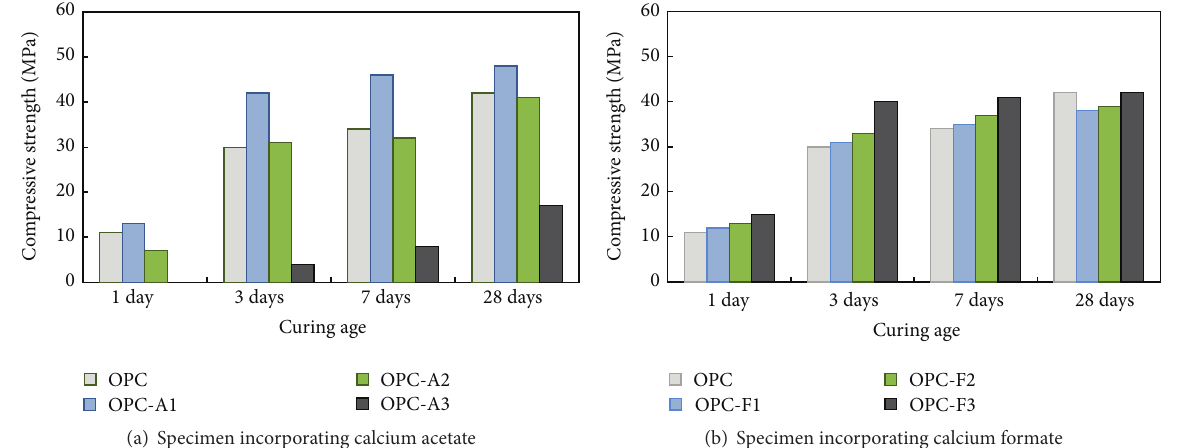
Figure 8: Compressive strength of specimens.